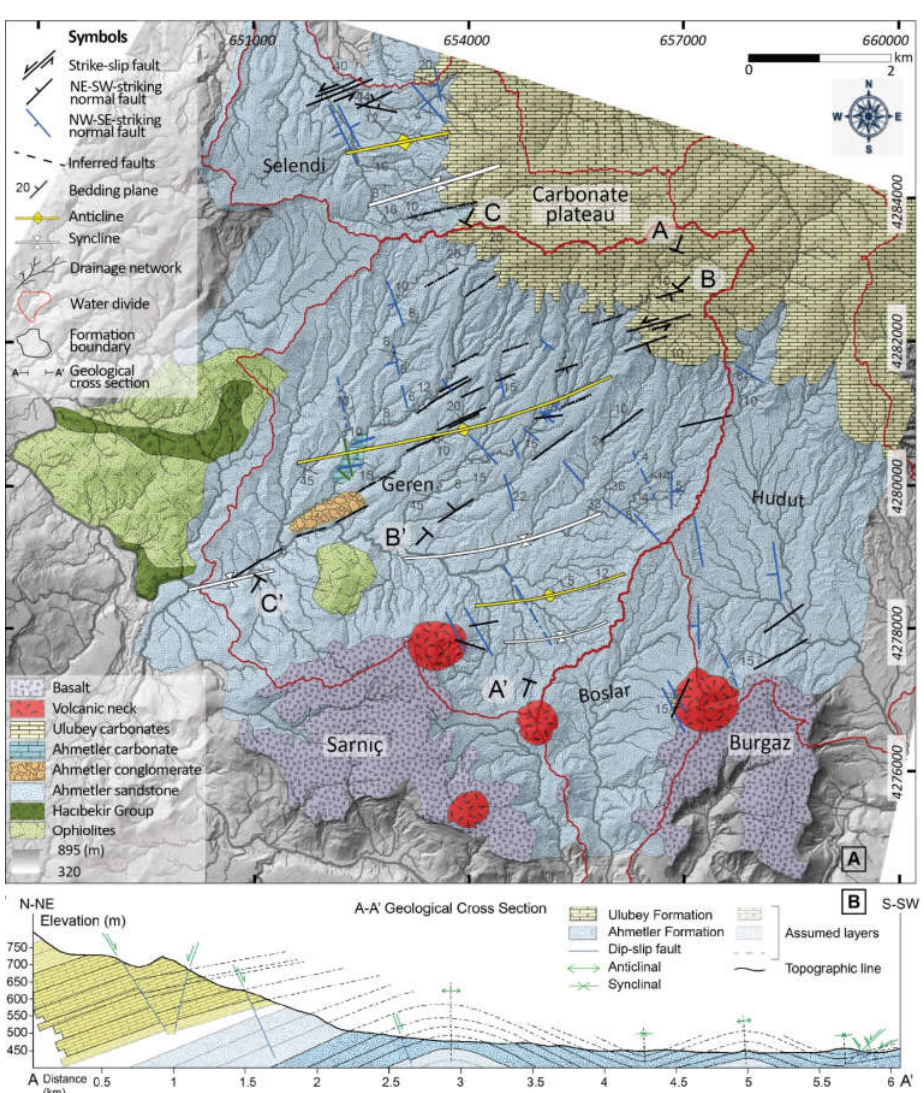
Figure 7. ( A ) Geological map of the Kula Basin with ( B ) cross section A-A’ (other cross sections are shown with B-B’ and C-C’, see text). Faults are shown with blue and black lines. Strike-slip faults are shown with blue lines with arrows. Yellow and white lines indicate anticlines and synclines. Grid in UTM Zone 35 coordinates. Modified after [39,46,90].